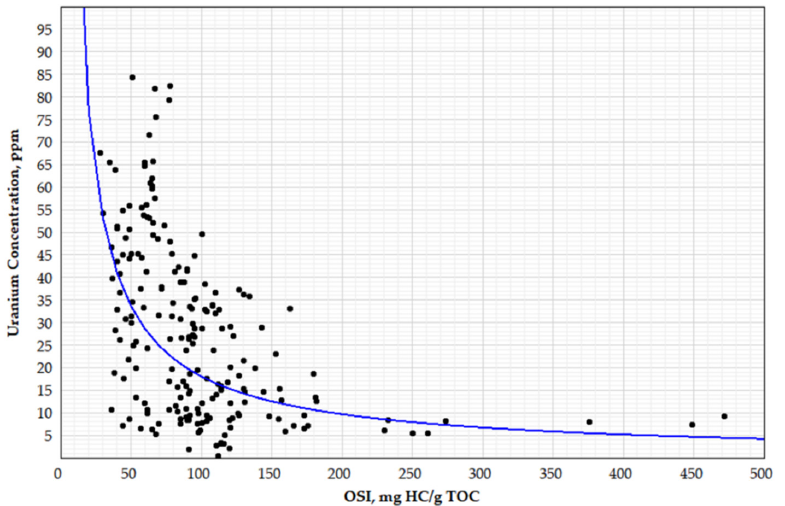
Figure 12. Uranium concentration as a function of oil saturation index (OSI) according to the study of 3 wells drilled at oil fields [26] characterized by low-maturity kerogen (Kgoc ≈ 55). Blue line corresponds to the equation U = 1133*OSI − 0.9 , where the determination coefficient R 2 = 0.25.